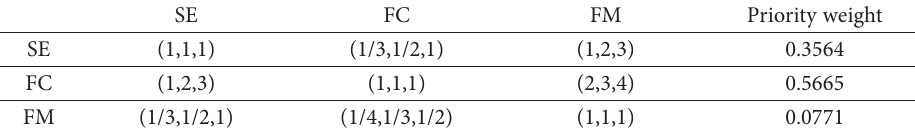
Table 8. Fuzzy evaluation of sub-factors as to perceived ease of uhse (PEU)